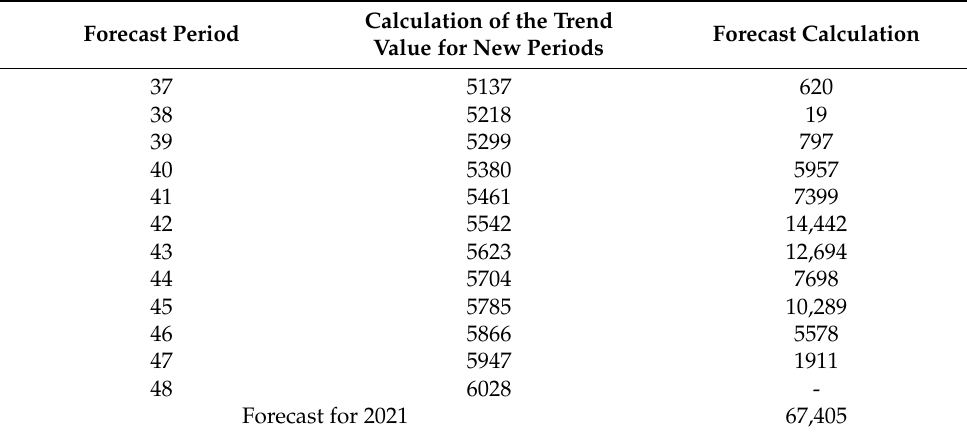
Table 5. Calculation of the sales forecast for